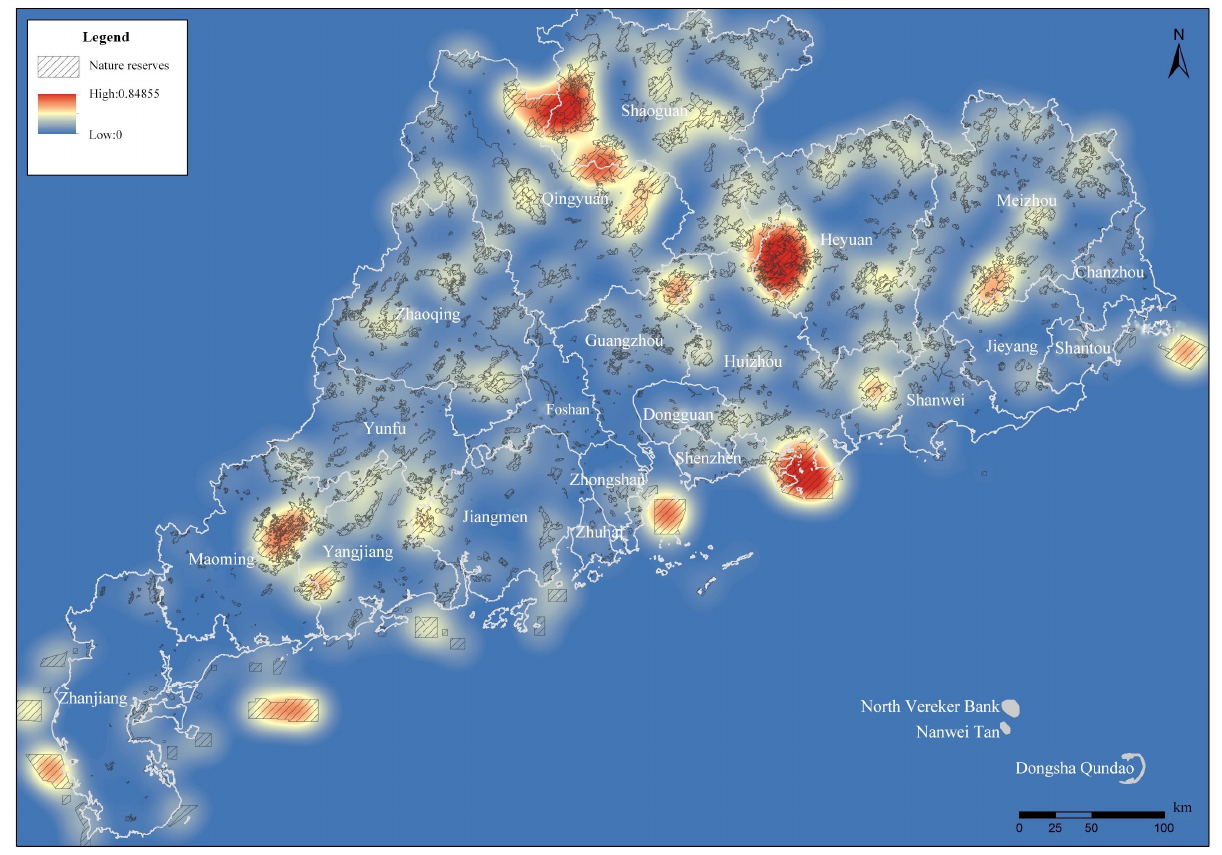
Figure 8. The results of integrated optimization of NPAs and kernel density analysis superposition.